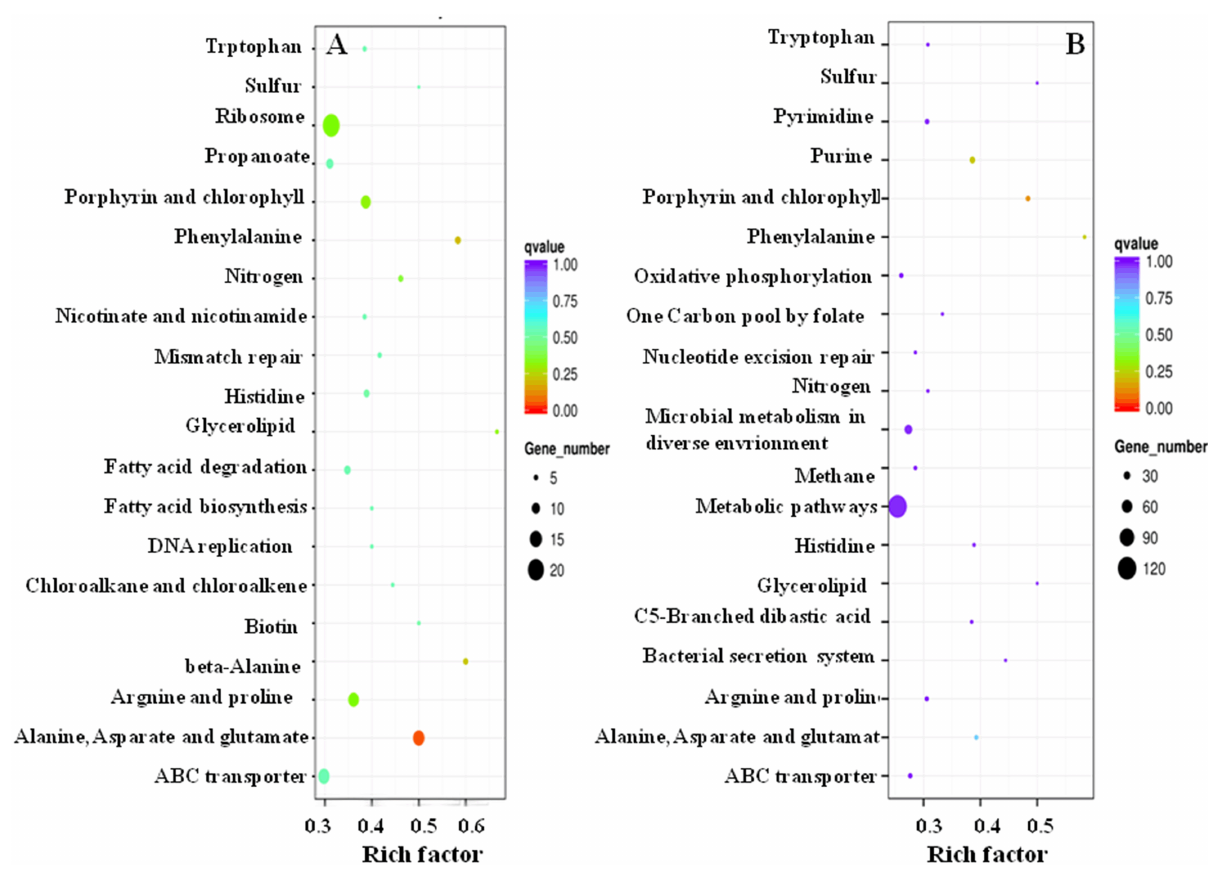
Fig 3. KEGG pathways of DEGs. A, cells in 15% vs 25% NaCl; B, cells in 25% vs 30% NaCl. The rich factor represents the degreeof enrichment of DEGs in a pathway; the size of a dot indicatesthe numberof DEGs, the color representsthe regionof the q-value—the closer to zero, the more highly